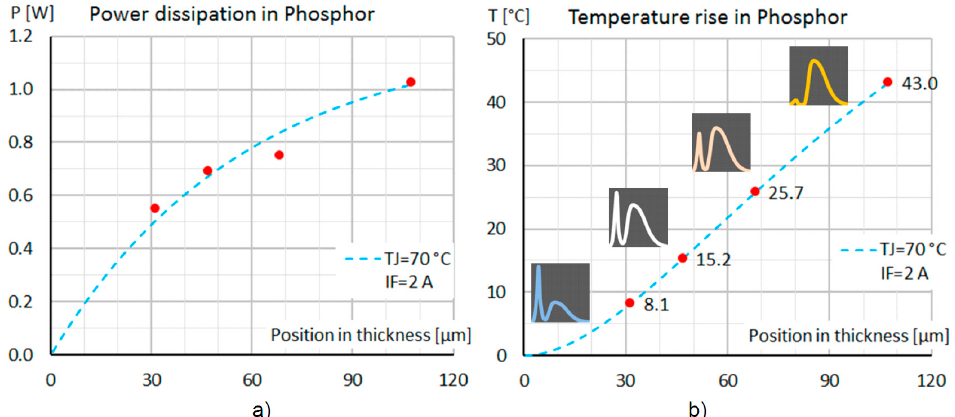
Figure 12. The layer thickness dependence of the major thermal properties of the custom-made phosphor layers identified from the measurements: ( a ) Thickness dependence of the total dissipation in the phosphor layer; ( b ) temperature rise of the phosphor layer.